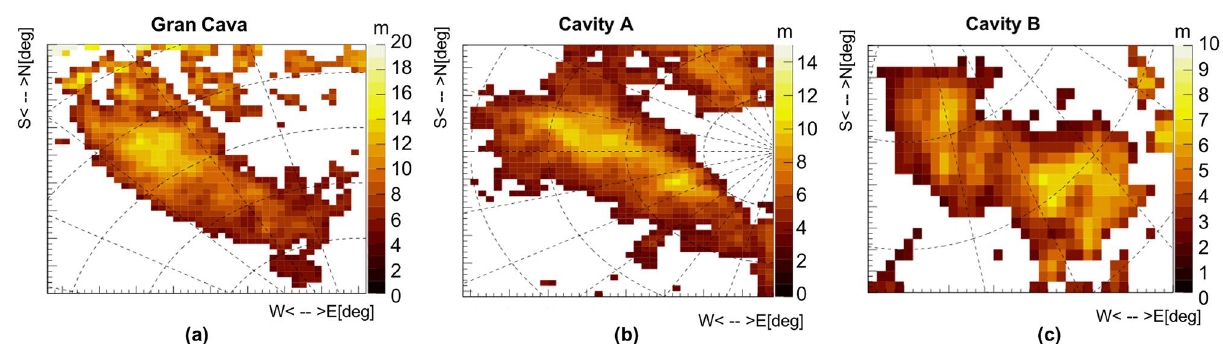
Figure 9. Two-dimensional cavity air thickness maps for the Gran Cava, and A and B signals. The images are obtained with the ROOT